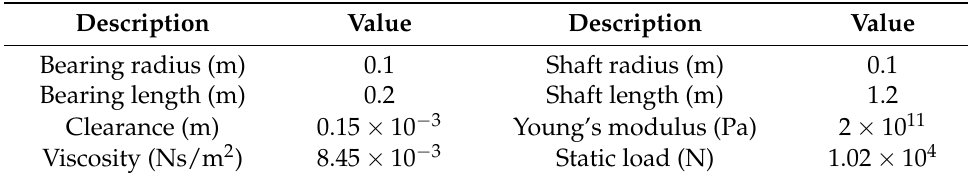
Table 1. Parameters of rotor-bearing system.